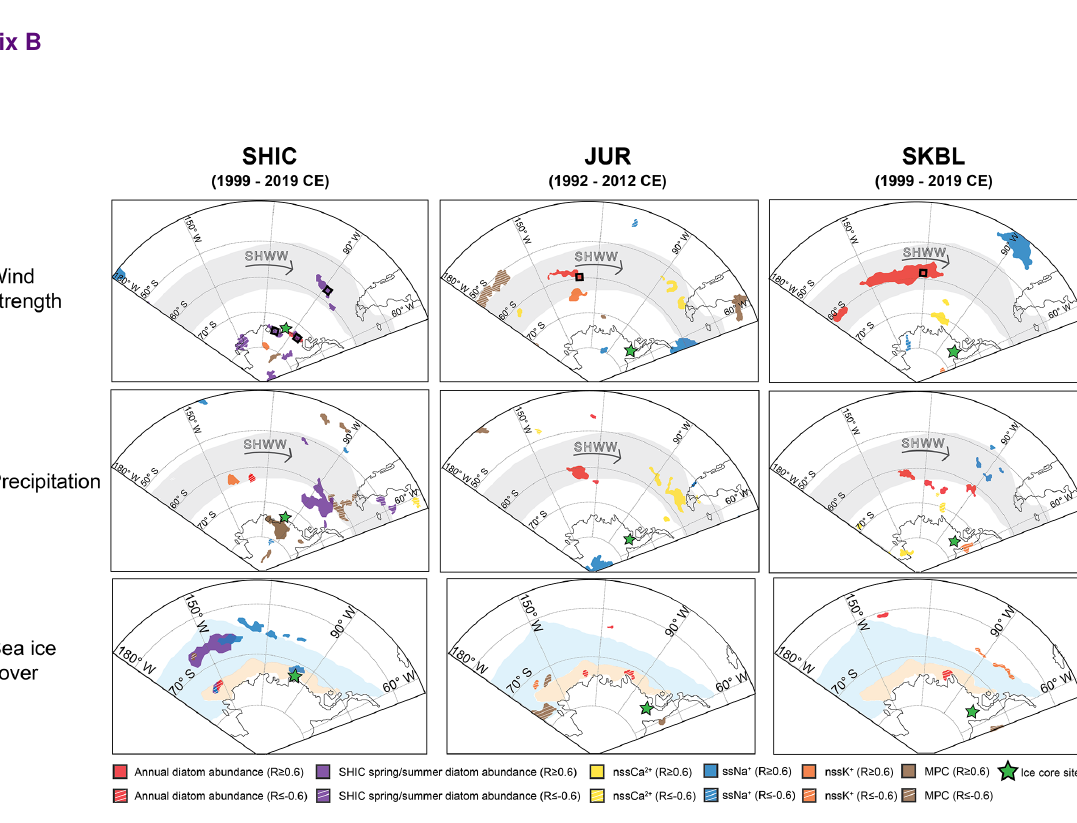
Figure B1. Regional maps showing spatial correlations between environmental parameters and chemical species, MPC and diatom abun- dance. Colour-coded polygons in the maps indicate highly correlated regions ( R ≥ 0 . 6 or R ≤ − 0 . 6). All polygons plotted are statistically significant ( p < 0 . 05). Pale grey latitudinal band indicates the core of the Southern Hemisphere westerly wind (SHWW) belt. Pale blue poly- gons indicate the region covered by seasonal sea ice. Pale orange polygons indicate the region covered by perennial sea ice. Black squares represent a 1 ◦ × 1 ◦ quadrant around the point of highest correlation (QHC) between wind strength and diatom abundance. Spatial correla- tions between MSA and environmental parameters were excluded because they were below the threshold ( R < 0 . 6, R > − 0 . 6 or p > 0 . 05). Regional maps only present areas of spatial correlation larger than 1 ◦ × 1 ◦ . Degrees of freedom (DF) for each spatial correlation can be obtained using the following expression dependent on the sample size ( n ); DF = n −